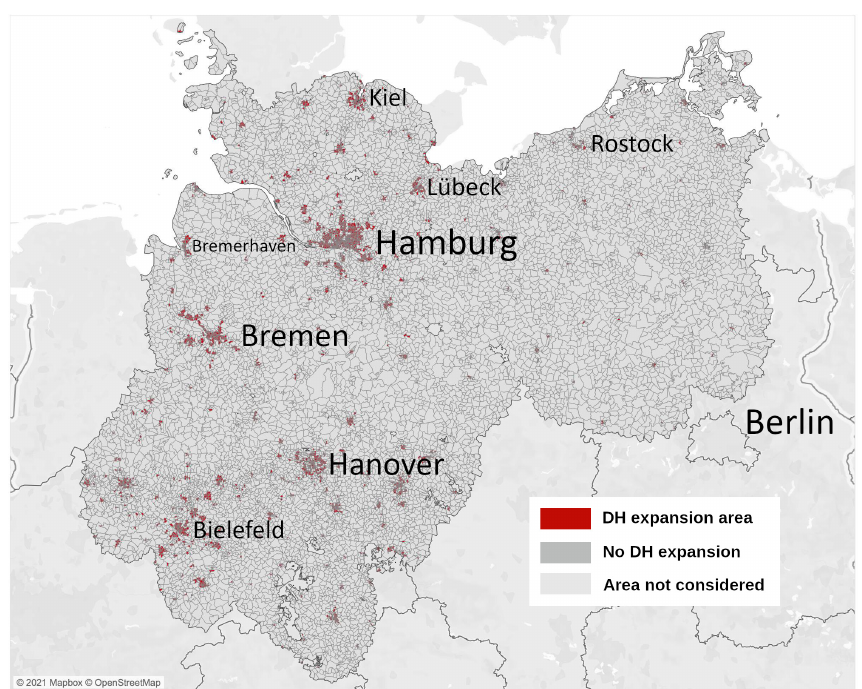
Figure 2. Approach 1 applied in Northern Germany: areas with suitable heat density for DH expansion are marked in red. Some city names have been added for reference. Berlin is outside the area of investigation. A similar dataset, which comprises the whole of Germany, is used in the